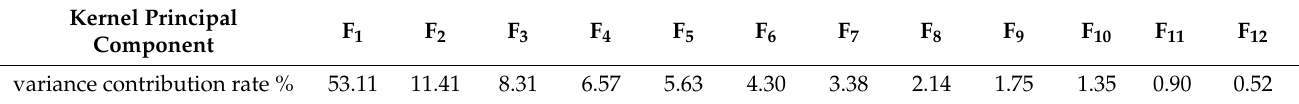
Table 3. Variance contribution rate.